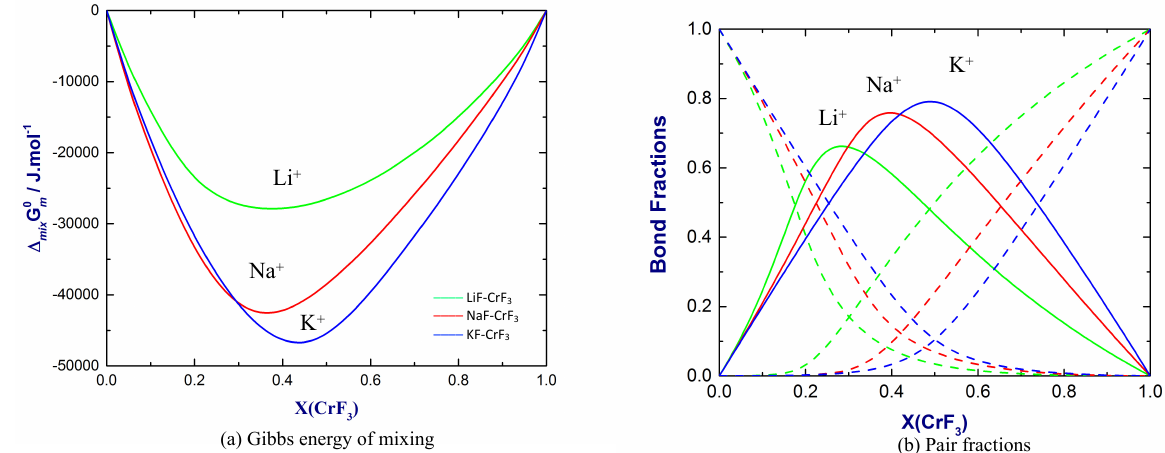
Figure 6. ( a ) Gibbs energies of mixing and ( b ) bond fractions of the LiF–CrF 3 , NaF–CrF 3 and KF–CrF 3 systems calculated from the present thermodynamic models at T=1500 K. Dashed lines starting at the left y axis: A–A–F–F, solid lines A–Cr–F–F, dashed lines starting at the right y axis: Cr–Cr–F–F pair